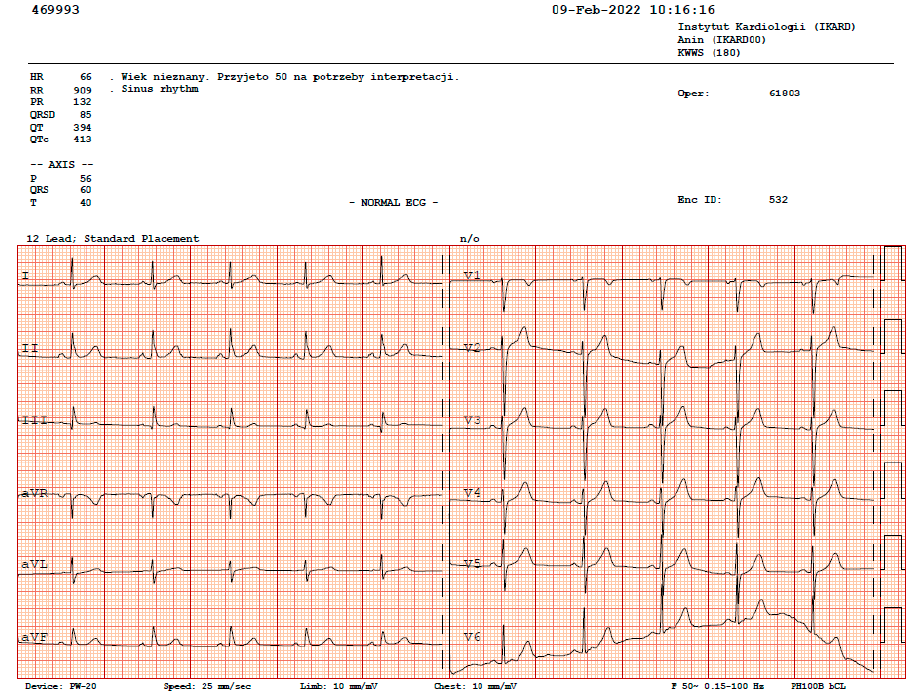
Figure 4. ECG of the examined athlete.